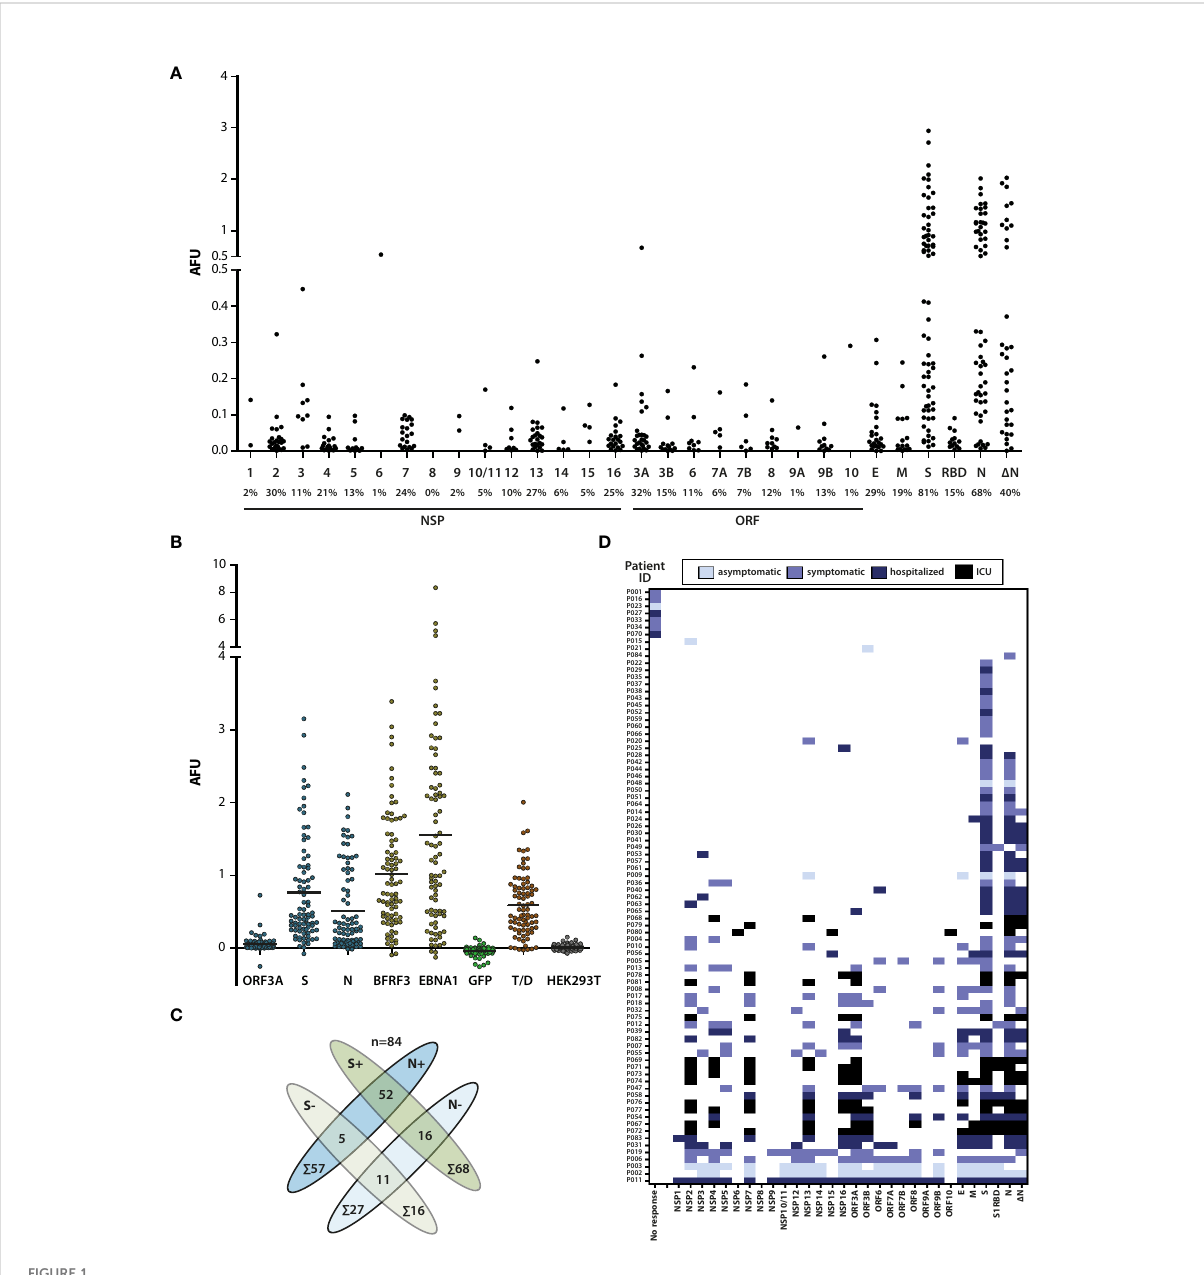
FIGURE 1 Broadness and magnitude of the SARS-CoV-2-speci fi c IgG response. (A) Sera of SARS-CoV-2-infected donors (n=84) were probed for IgG responses against the SARS-CoV-2 proteome. IgG antibody responses are represented as arbitrary fl uorescence units (AFU). The names of the viral proteins are depicted on the X-axis (NSP, non-structural protein; ORF, open reading frame) and the percentage of responding donors is indicated below the protein name. Only signal values above cutoff are shown. RBD, S protein receptor-binding domain; D N, nucleoprotein lacking aa 1-120. (B) Comparison of the magnitude of the antibody responses against ORF3A, S, N, and the major Epstein-Barr virus antigens BFRF3 (VCAp18) and EBNA1, as well as tetanus/diphtheria (T/D) antigens. GFP and HEK-Lysate puri fi ed over Nickel-NTA beads were used as controls. Total values are shown (no cutoff applied). Mean value of responses (horizontal lines): ORF3A: 0.054; S: 0.764; N: 0.510; BFRF3: 1.024; EBNA1: 1.553; GFP: -0.034; Tet/D: 0.593; HEK293T: 0.009. (C) Antibody responses against N and/or S protein. 68/84 donors showed responses against S and 57/84 against N. 52 donors had responses against both proteins, while 5 had responses against N and 16 responses against S only. (D) Individual antibody responses of SARS-CoV-2-infected donors with color-coded clinical grading. IgG responses against one or several viral antigens were detected in 77 SARS-CoV-2 infected donors while no virus-speci fi c antibody responses above cutoff were detected in 7